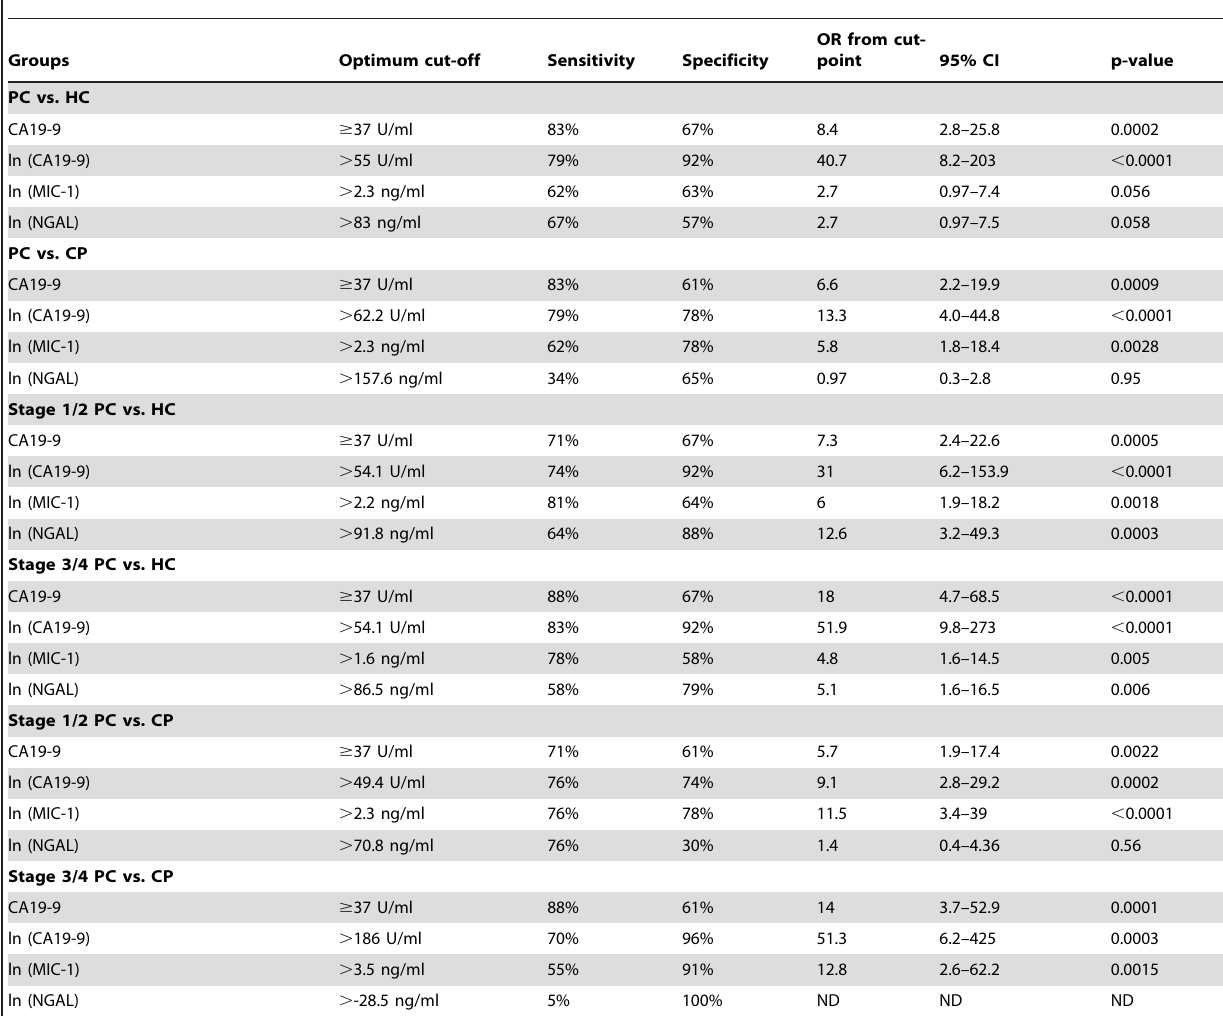
Table 4. Determining optimum cut-off of CA19-9, NGAL and MIC-1 for diagnosis of pancreatic cancer ? .